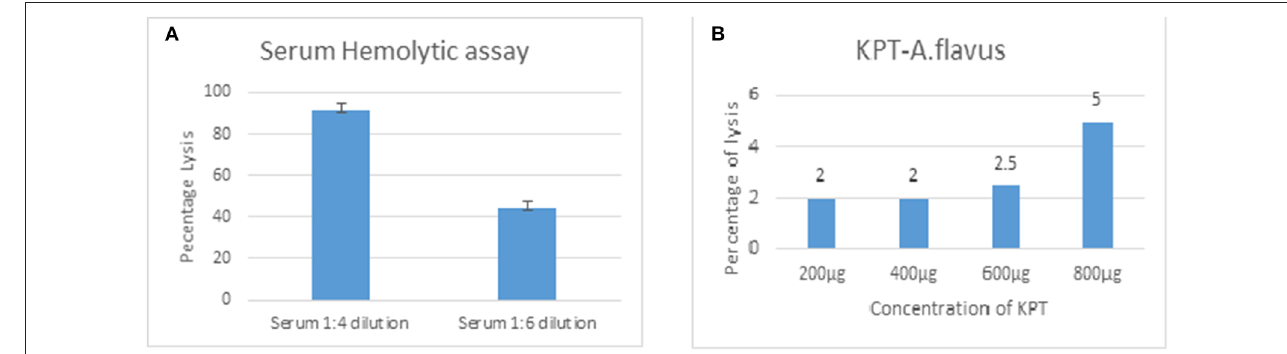
FIGURE 6 | Functional assay of complement proteins. Different concentrations of human serum (A) or A. flavus keratitis patient tear (B) was added to 1 × 10 8 to rabbit RBCs and incubated in DGHB buffer for 60min at 37 ◦ C. After centrifugation, the supernatant was collected and the absorbance measured at